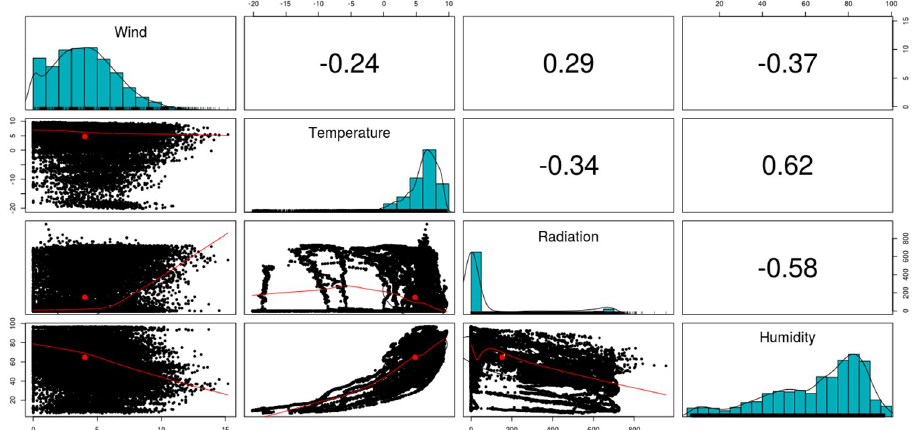
Fig 8. Pairwise representations adopting the Phase II observations, and their Spearman